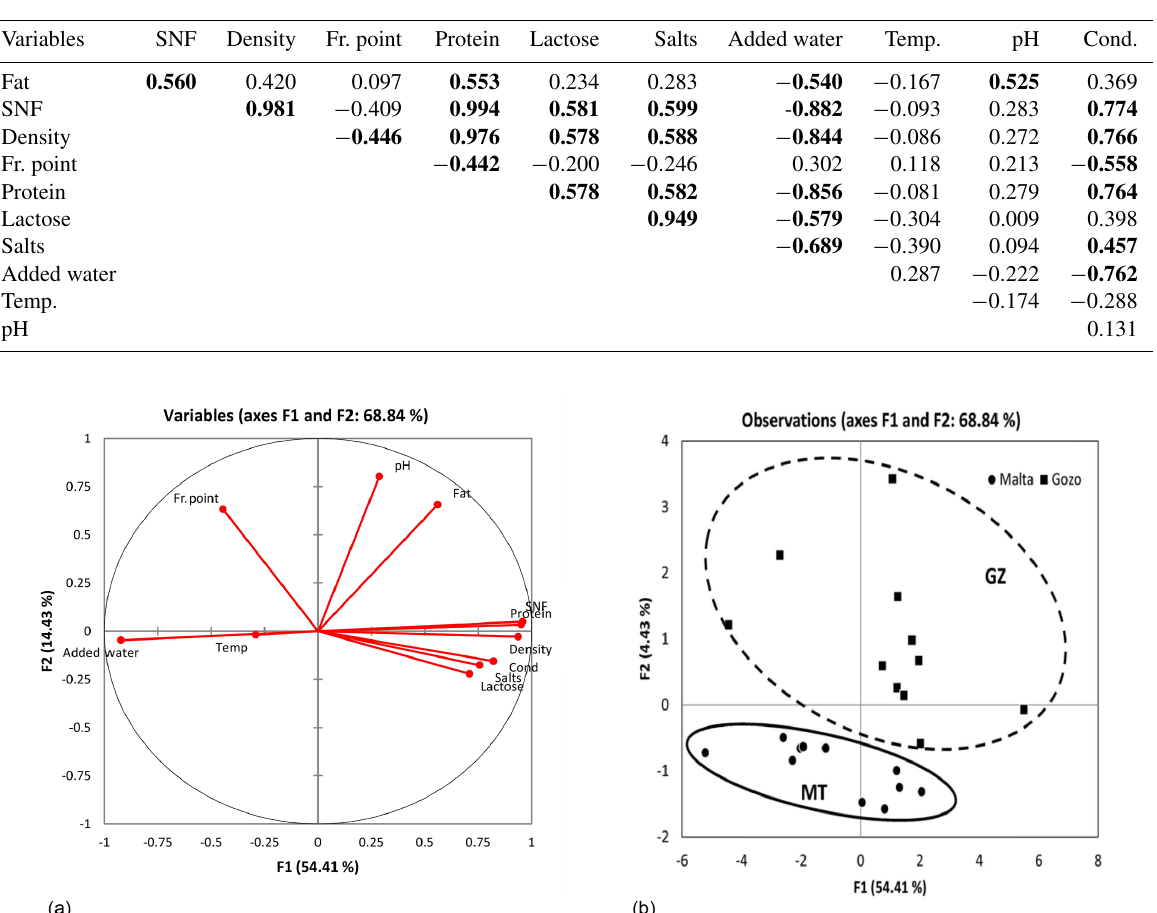
Figure 1. (a) The factor loading plot demonstrating the different groups of variables; (b) the factor scores of the two latent factors.